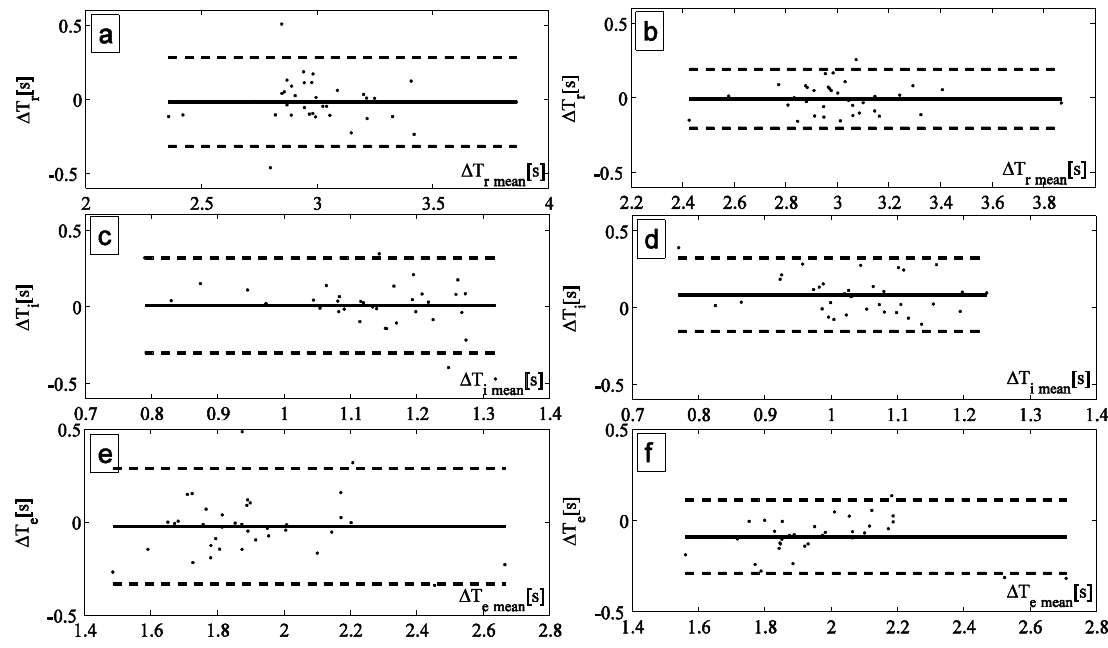
Figure 4. ( a , b ) Bland Altman plot comparing the respiratory period measured by OEP and by the smart textiles with the automatic method and the manual one, respectively; ( c , d ) Bland Altman plot comparing the inspiratory period measured by OEP and by the smart textiles with the automatic method and the manual one, respectively; ( e , f ) Bland Altman plot comparing the expiratory period measured by OEP and by the smart textiles with the automatic method and the manual one, respectively.